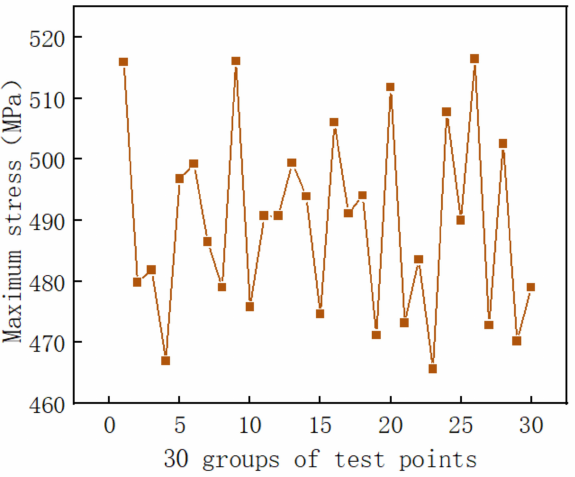
Figure 16. Maximum stress curve of 30